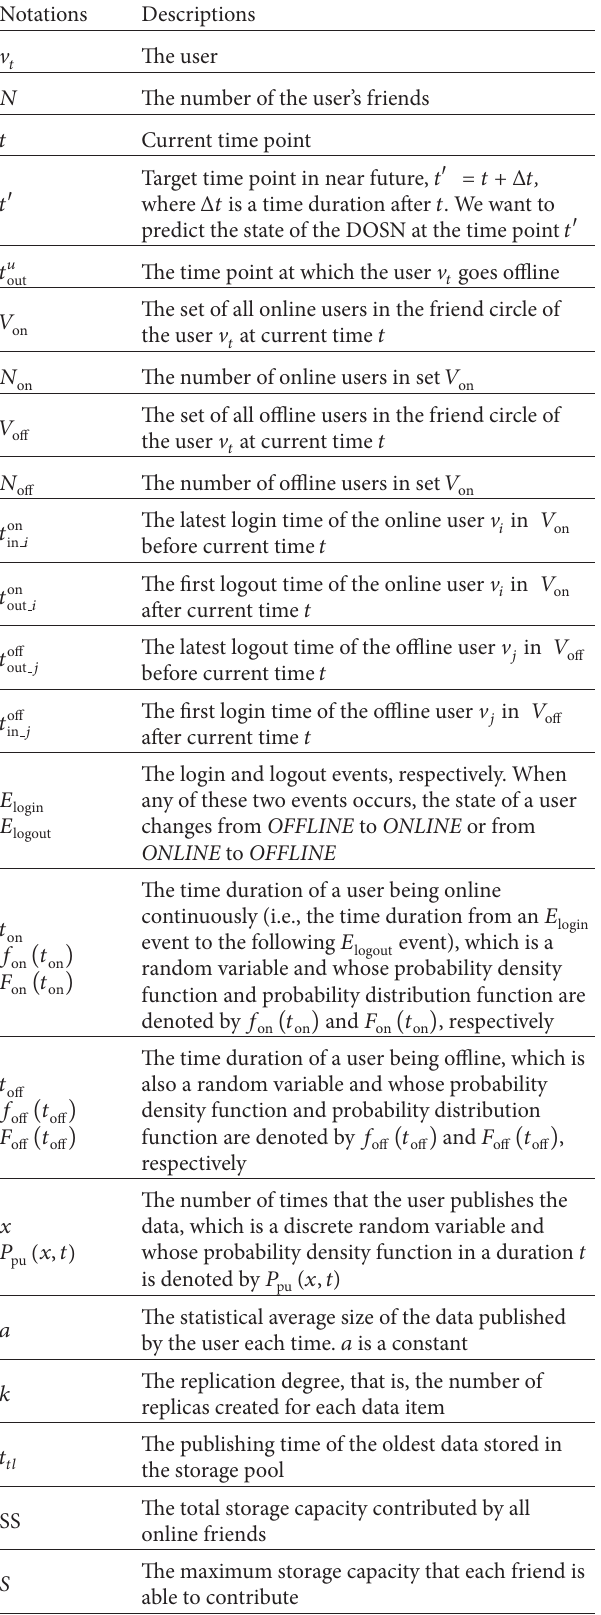
Table 1: The notations that are used in the